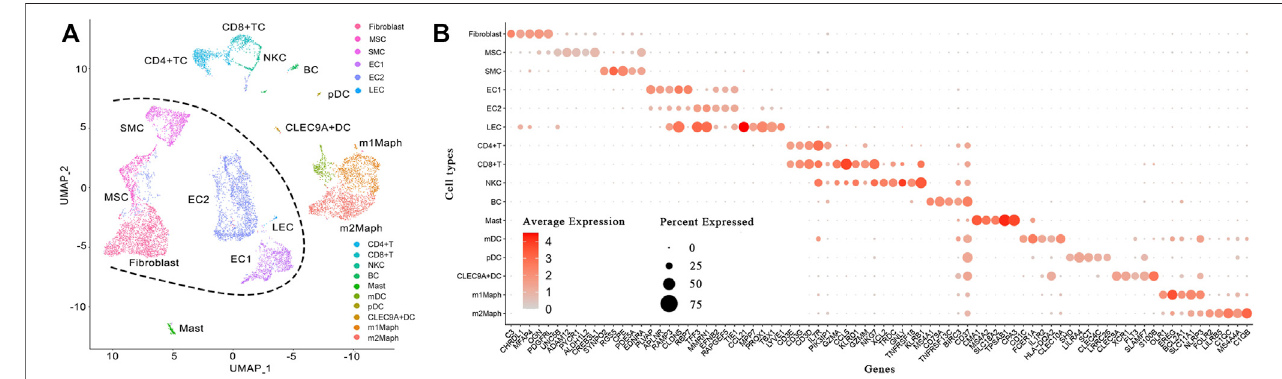
FIGURE 1 | Identi fi cation of 16 cell types in a cavernous hemangioma. A total of 10,784 cells were fi nally clustered into 16 clusters and then identi fi ed as 16 cell types.Thenon-immunecelltypes( fi broblast,MSC,SMC,EC1,EC2andLEC)wereclearlyseparatedfromimmunecelltypes(CD4+TC,CD8+TC,NKC,BC,mast,mDC, pDC, CLEC9A + DC, m1Maph and m2Maph) by a borderline (named Nankai borderline in the present study). (A) . Uniform Manifold Approximation and Projection (UMAP)methodwasusedtoshowtheclusteringresults; (B) .Foreachofthe16clusters,acombinationof fi vemarkergenes(thesymbolsof80genescanbeseen in Table1 )wereassigned.MSC:mesenchymalstemcell,SMC:smoothmusclecell,EC1:endothelialcelltype1,EC2:endothelialcelltype2,LEC:lymphaticendothelial cell, CD4+TC: CD4 positive T cell, CD8+TC: CD8 positive T cell, NKC: natural killer cell, BC: B cell, mDC: monocyte derived dendritic cell, pDC: plasmacytoid dendritic